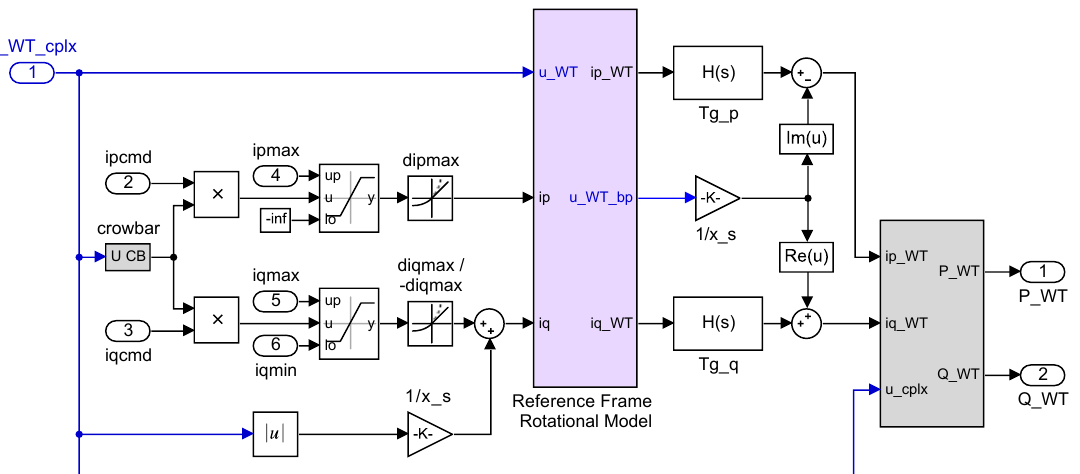
Figure 5. Electrical generator system of the IEC 61400-27-1 generic Type 3B model implemented in Simulink.